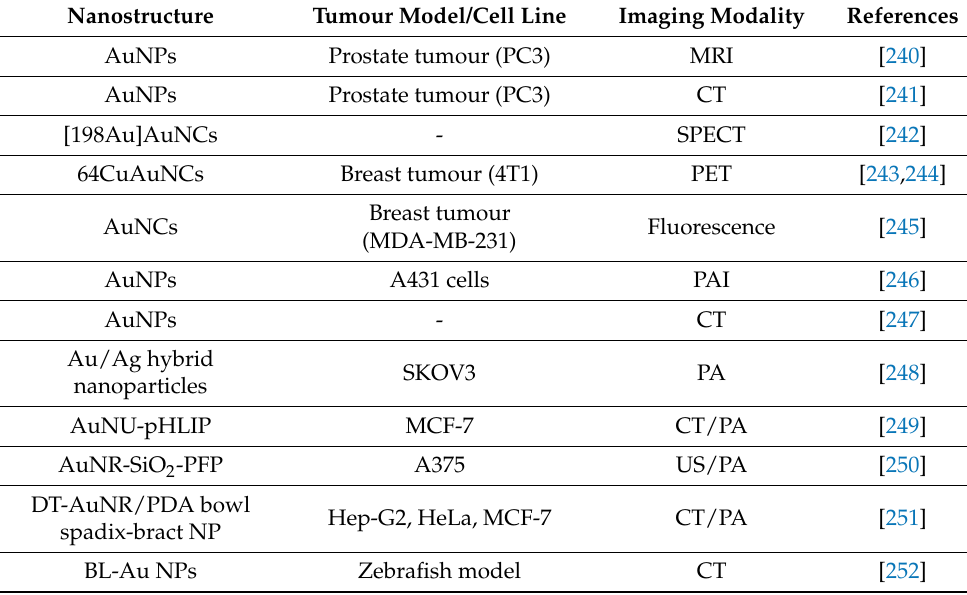
Table 4. Gold nanostructures used in imaging-based